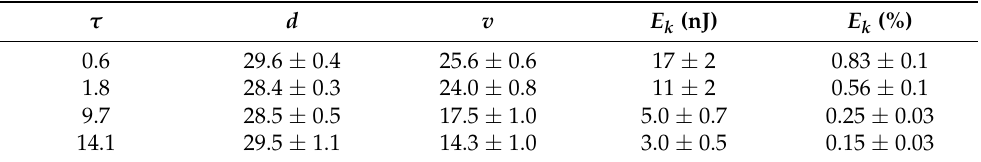
Table 1. Jet width and velocity of the jets in dependency of the laser pulse duration. Obtained ki- netic energy for the jet propagation and corresponding energy conversion efficiency.